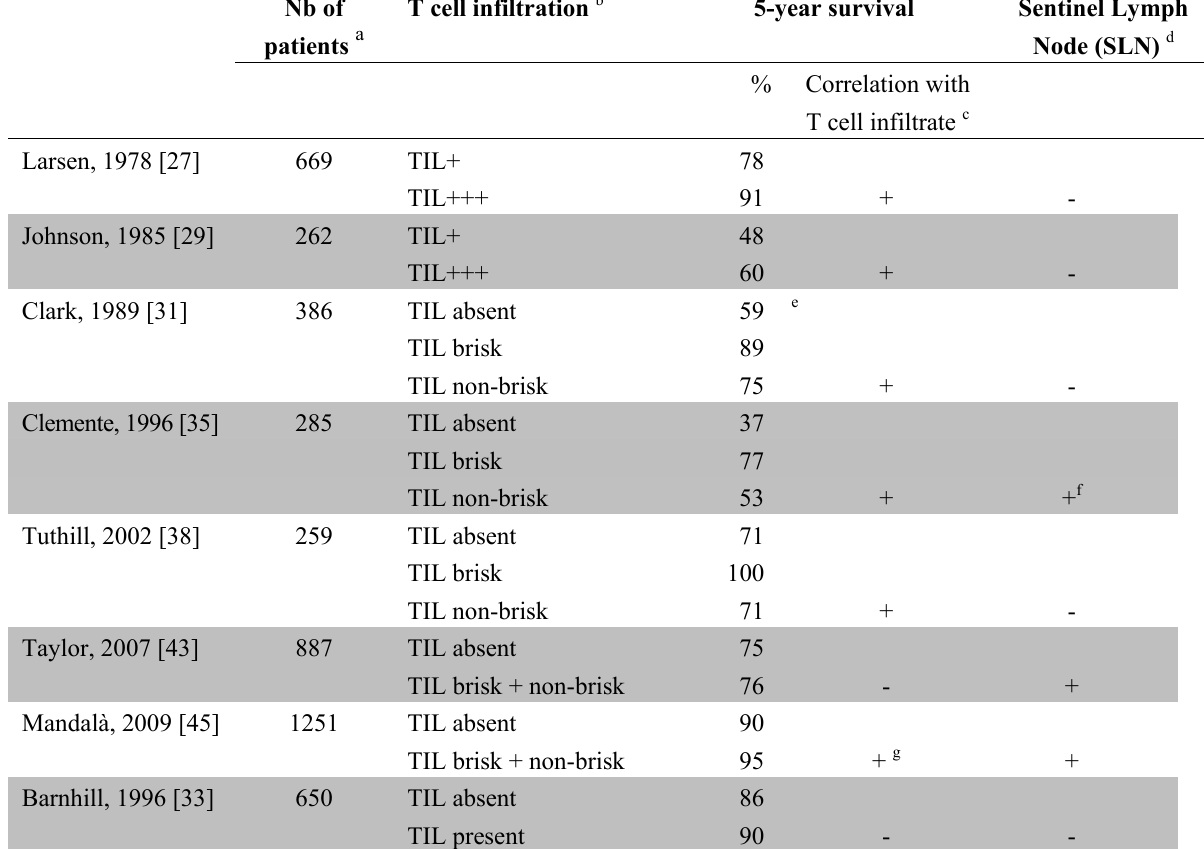
Table 1. Patient survival and presence of tumor-infiltrating lymphocyte (TIL) in primary melanoma. Nb